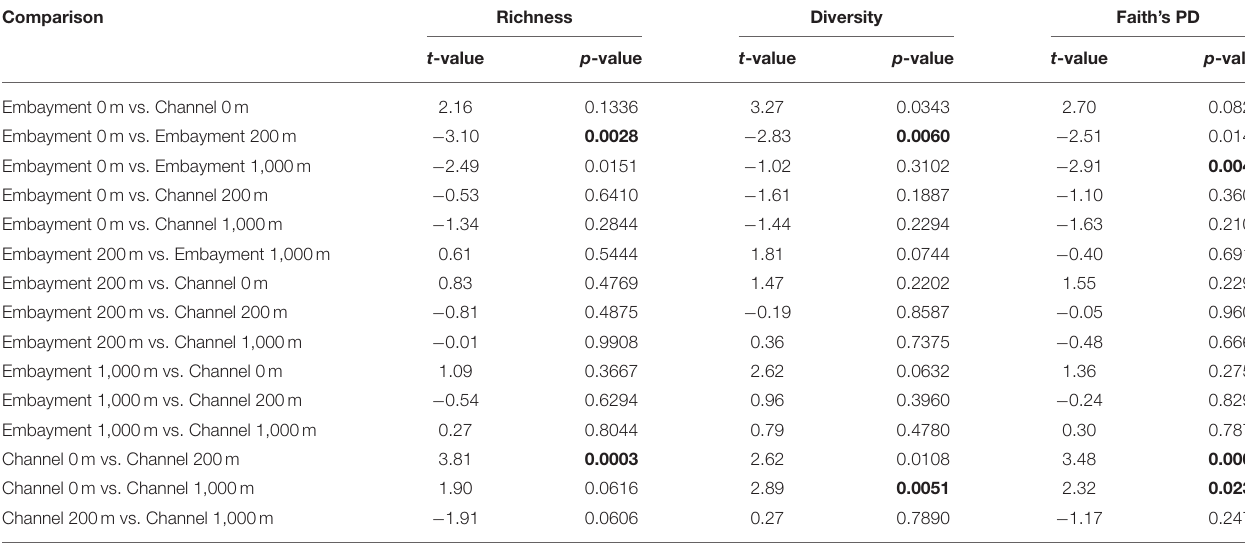
TABLE 2 | Statistical results of the pairwise comparisons investigating differences in bacterial (a) richness, (b) diversity and (c) Faith’s PD. Comparison